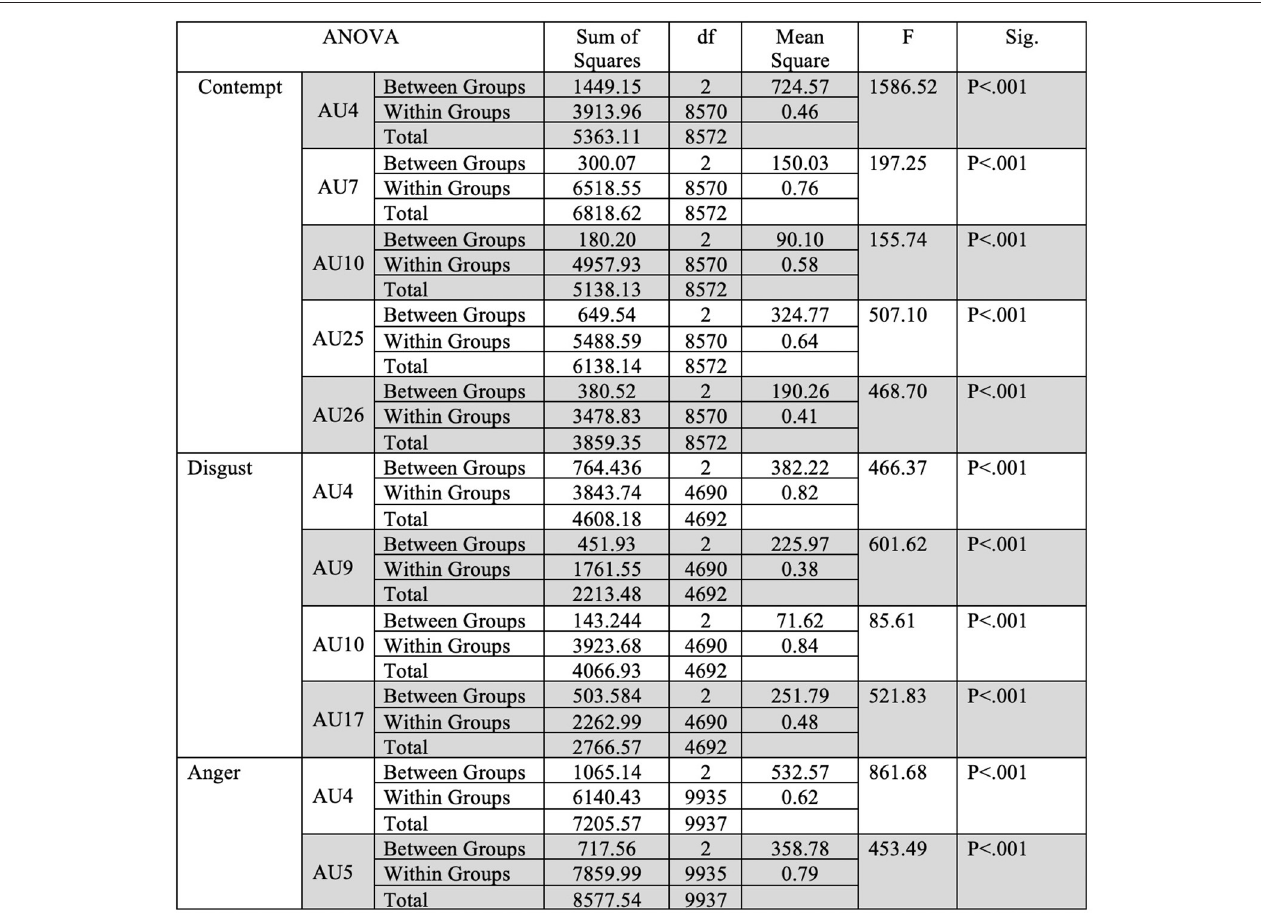
FIGURE 2 | Descriptive statistics for the one-way ANOVA for each emotion across all